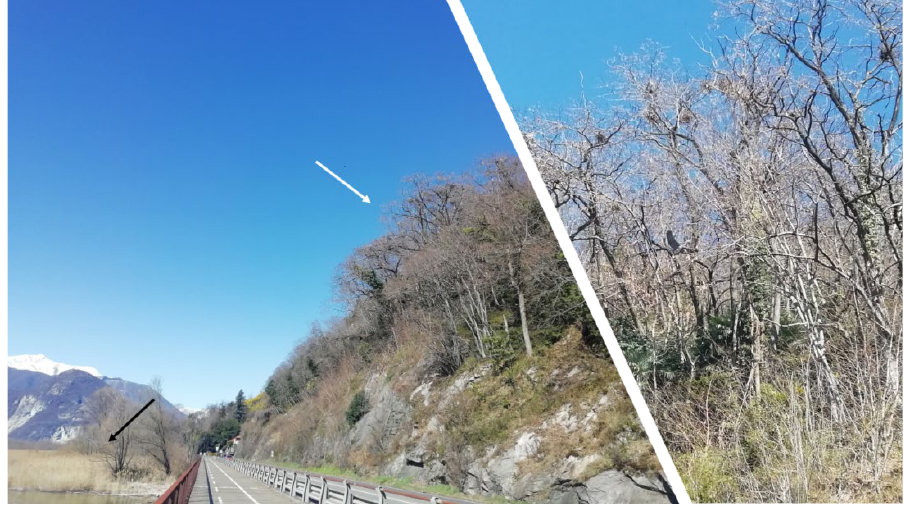
Figure 5. The heronry ( white arrow ) near the Fondotoce Nature Reserve ( black arrow ) in Lake Maggiore.